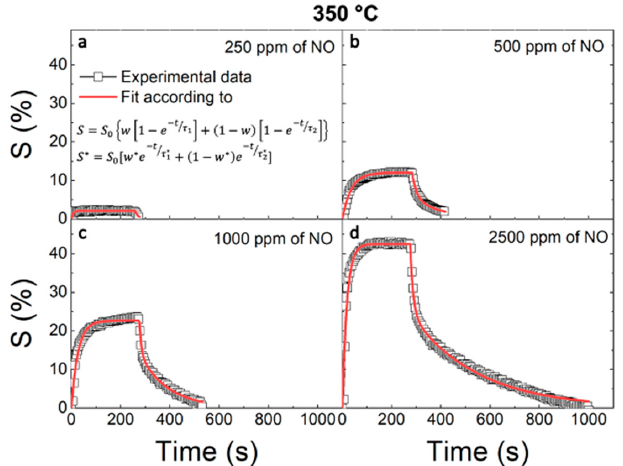
Figure 3. Dynamic responses of the WO 3 -based sensor (squared symbols) and the fit (red lines) obtained at ( a ) 350, ( b ) 300, and ( c ) 250 ◦ C under 500 ppm of NO as a function of elapsed time, starting when NO was fluxed into the chamber.